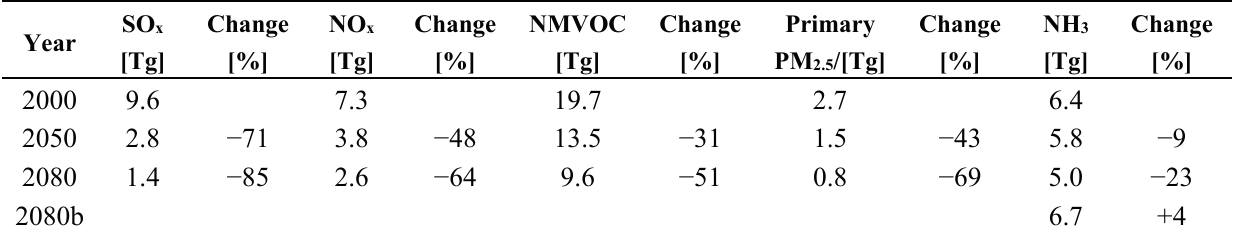
Table 1. RCP4.5 emissions (Tg) as total for the European domain for 2000, 2050 and 2080. The changes in % relative to the emissions in 2000 are also given. The numbers marked with red corresponds to the additional 2080b scenario for